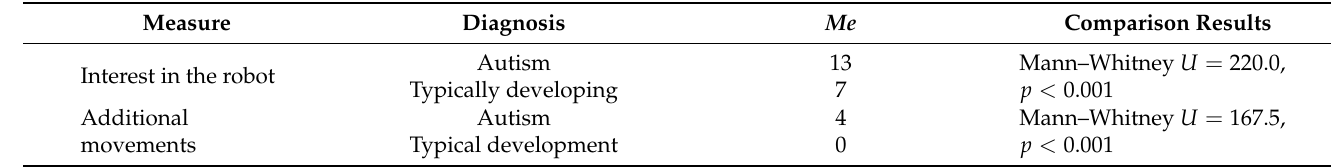
Table 4. Results of non-parametric (Mann–Whitney) comparison of autistic vs. typically developing children in the additional measures, i.e., Interest in the robot and Additional